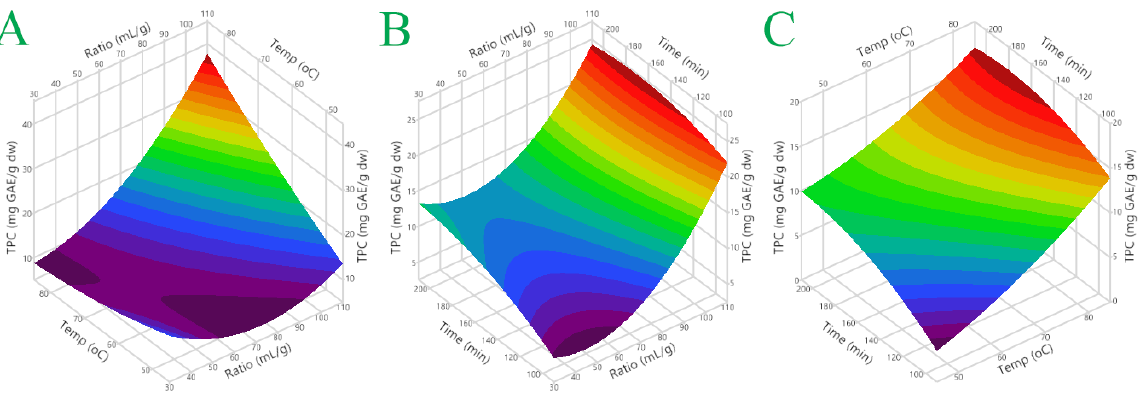
Figure 2. For the extraction of APW using DES-2, 3D graphs showing the impact of the process variables taken into consideration on the response. Plots ( A , B ) show the covariation of X 1 ( R ) and X 2 ( T ), X 1 ( R ), and X 3 ( t ), and ( C ) the covariation of X 2 ( T ) and X 3 ( t ).